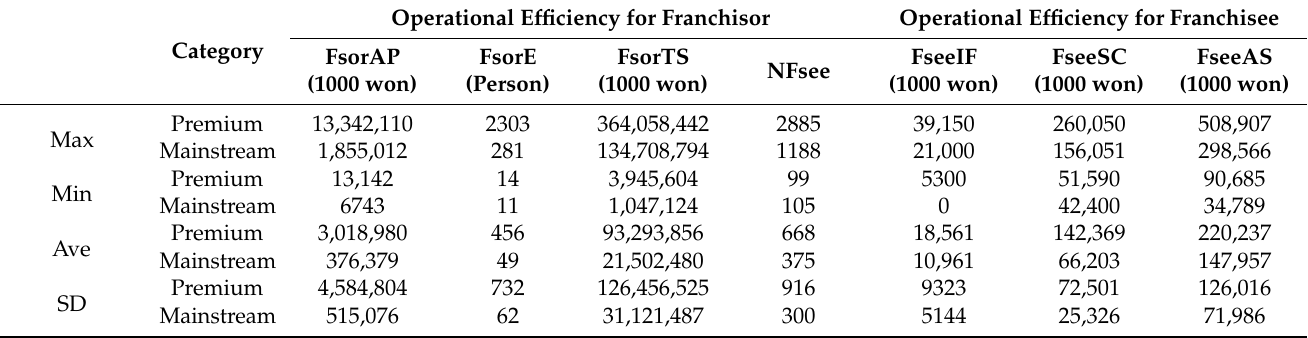
Table 2. Input and output variables in the Korean coffee shop